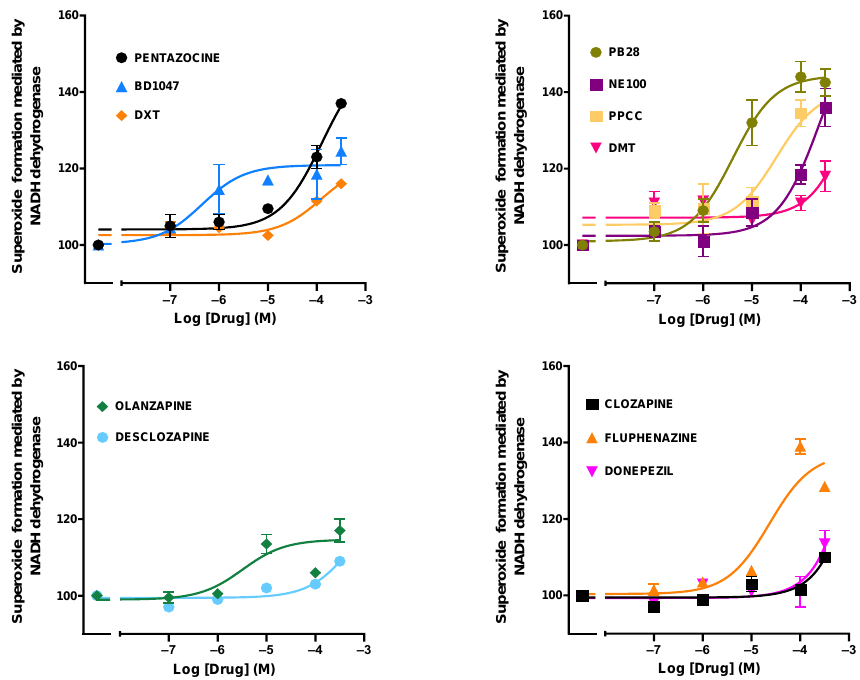
Figure 3. Concentration–response curves of superoxide formation in isolated bovine heart membranes induced by NADH dehydrogenase modulation with pentazocine, BD1047, DXT, PB28, NE100, PPCC, DMT, olanzapine, desclozapine, clozapine, fluphenazine, and donepezil. The superoxide formation promoted by NADH dehydrogenase is represented in percentages versus the activity measured in absence of the tested drug. Nonlinear regression was performed with the log (agonist) vs. response (three parameters) model and least squares regression as fitting